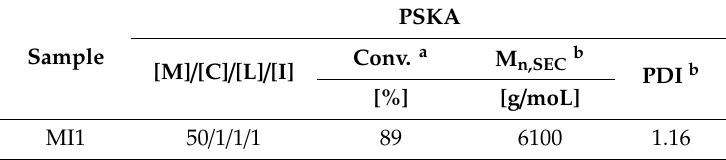
Table 8. Synthesis of the poly(solketal acrylate) macroinitiator.